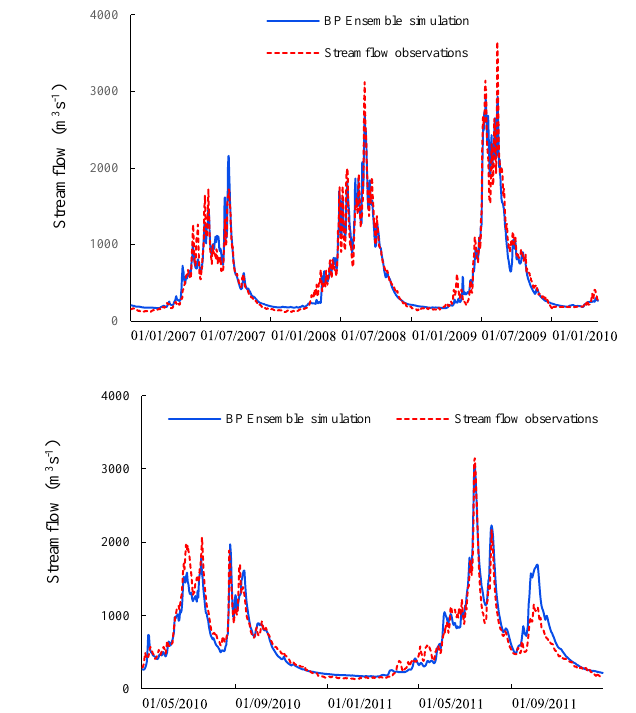
Figure 6. BP ensemble simulated streamflow for the basin in both the calibration and validation